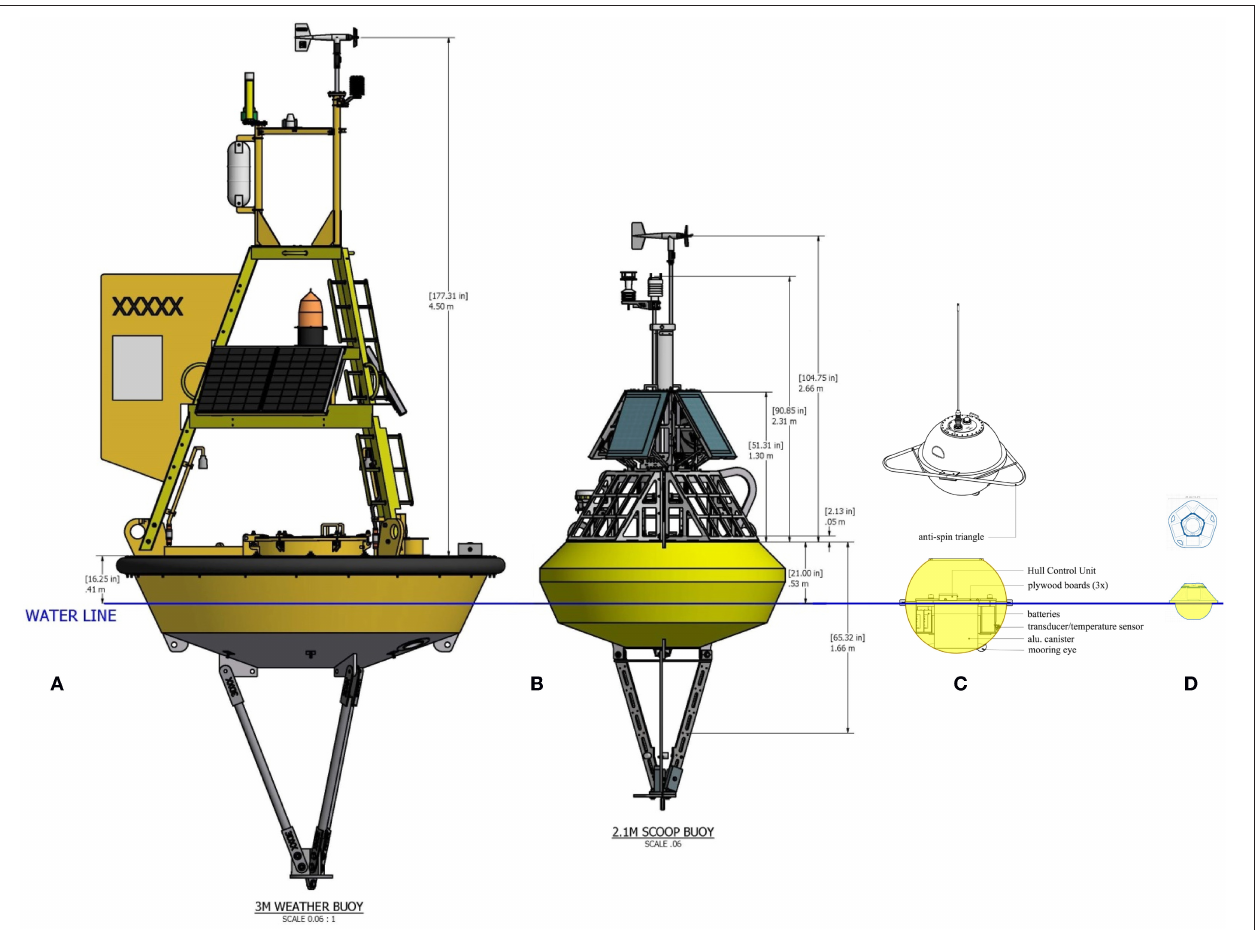
FIGURE 12 | Schematics of existing and planned super-structures of NDBC moored buoys measuring waves, (credit Eric Gay, NDBC). (A) is the standard design of 3-m discus buoys ( Steele et al., 1992) pictured in Figure 1A , (B) is the new SCOOP design with a 2.1 m diameter that is replacing many buoys. The 3-m diameter SCOOP is pictured in Figure 1B . For reference, (C) is the schematic for the Mark 4 Datawell waverider with a 0.9 m hull diameter, drawn to scale, and (D) is the schematic of a Spotter buoy made by Spoondrift, following the developments of Herbers et al.